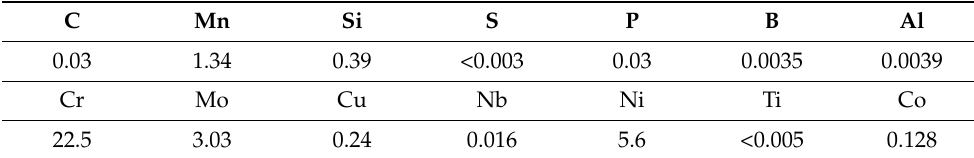
Table 1. Chemical composition of Duplex 2205 stainless-steel in (wt%). C